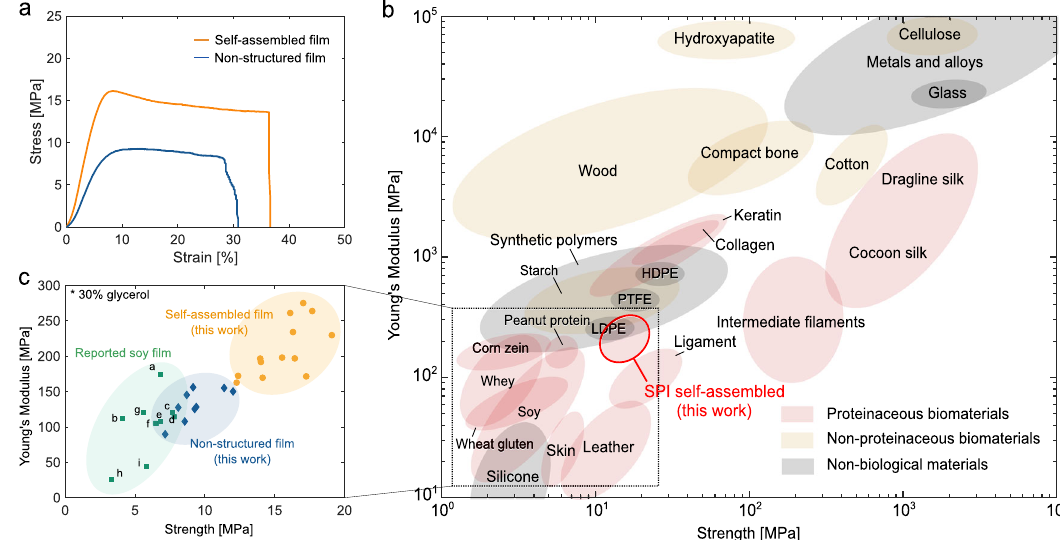
Fig. 4 Mechanical properties of the self-assembled SPI fi lm. a Representative stress – strain curves for the dried nonstructured and the dried self- assembled fi lms. b Mechanical properties of self-assembled SPI fi lm in comparison to previously reported biomaterials, engineered materials 6,71,72 , and plant-based materials (see Supplementary Table 2 for references). c Zoomed-in graph for self-assembled (orange), nonstructured (blue), and previously reported SPI fi lms (green, the details of references are in Supplementary Table 3).